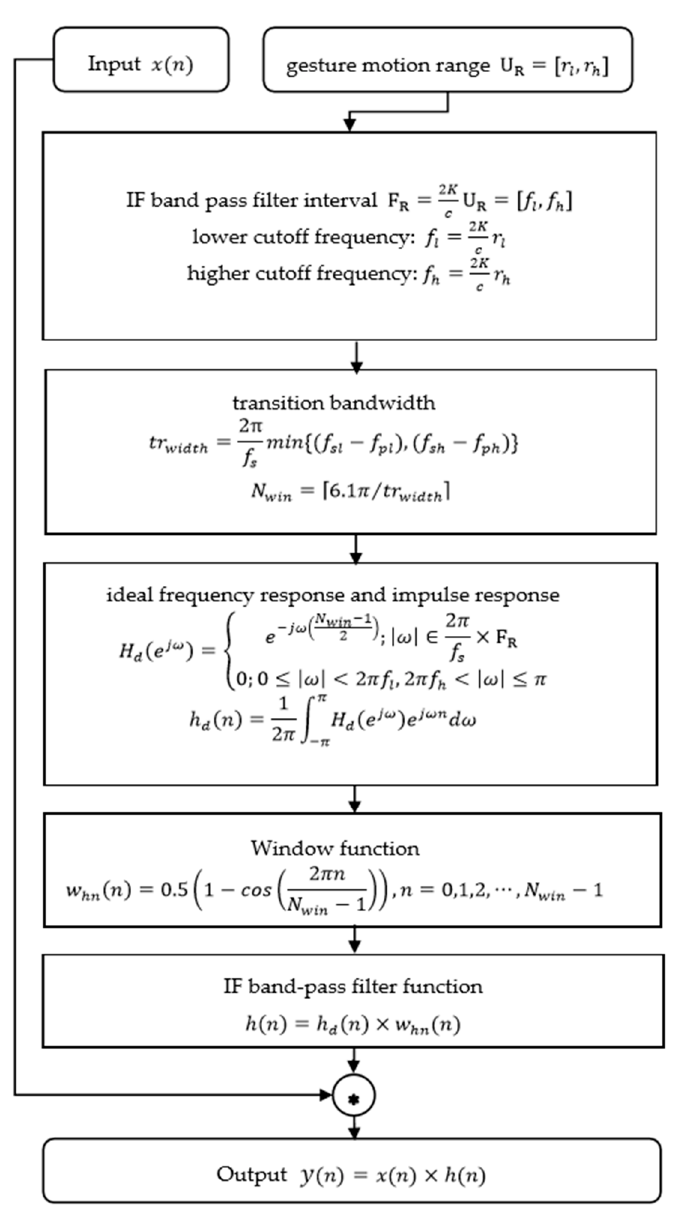
Figure 6. Block diagram of proposed IF-BPF algorithm.